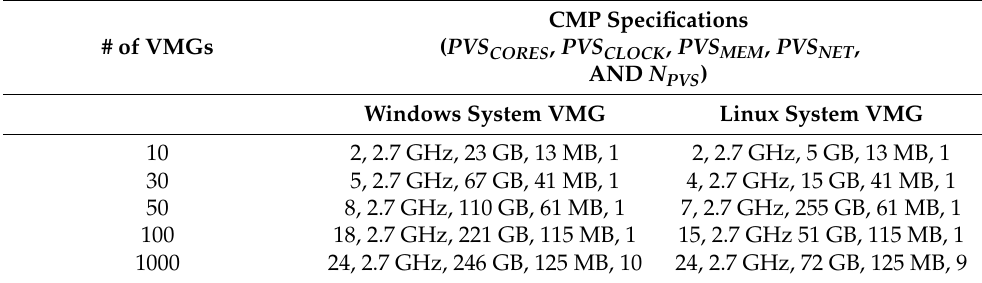
Table 5. Server capacity degradation parameters of CPU and MEM.